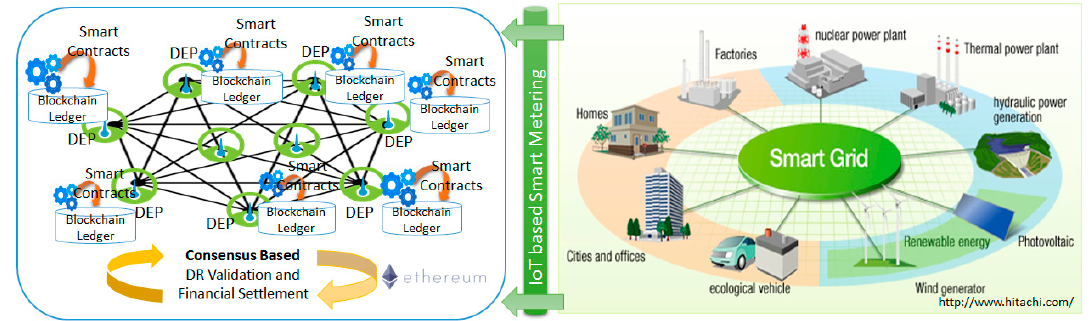
Figure 3. Blockchain based architecture for decentralized management of energy grids.